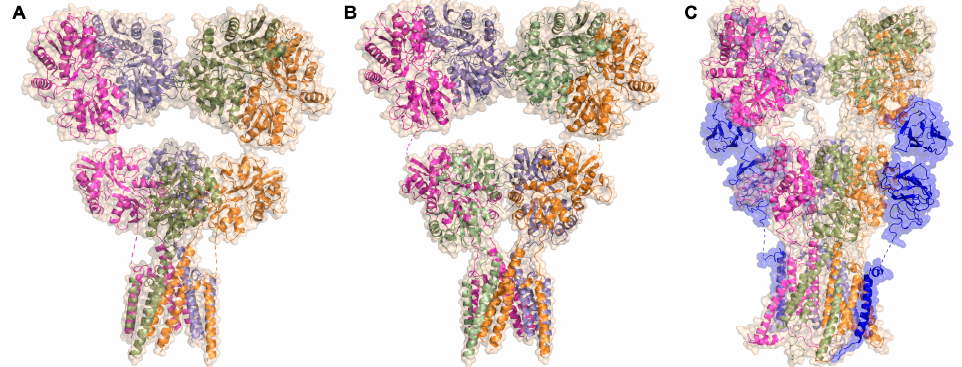
Figure 2. ( A ) Cryo-EM structure of the GluK2/5 heterotetramer in glutamate ( L -Glu) bound state (PDB code: 7KS3); ( B ) cryo-EM structure of the GluK2/5 heterotetramer in the 6-cyano-7-nitro- quinoxaline-2,3-dione (CNQX) bound state (PDB code: 7KS0); ( C ) cryo-EM structure of homo- tetrameric GluK2 in complex with NETO2 and DNQX, NETO2 shown in dark blue (PDB code: 7F5A).